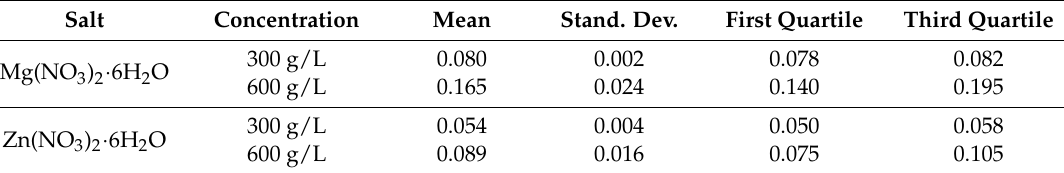
Table 4. Statistical description of Mg/P and Zn/P ratios based on atomic percent.